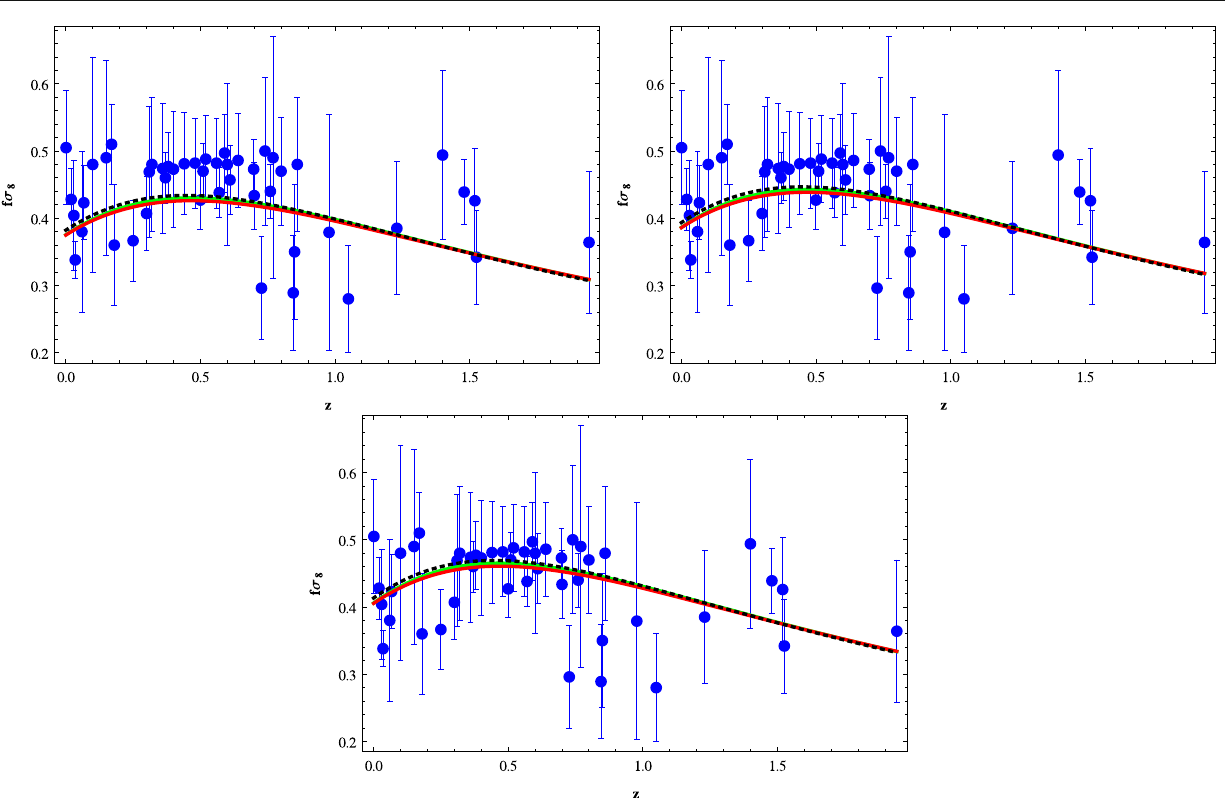
Fig. 4 The evolutionary trajectory of f σ 8 , as a function of redshift z , lutions of f σ 8 in a (cid:2) CDM and GCG models, respectively. Also, the is shown for the present model (green curve) by considering the values blue dots (with the error bars) correspond to the 47 Growth of mat- of (cid:6) b 0 = 0 . 046 ,(cid:6) dm 0 = 0 . 2508 ,ω de = − 1 . 041 , A s = 0 . 7373, and ter data points (redshift space distortions measurements) in the redshift η = 0 . 9443.Theplotsarefor σ = 0 . 75[61](leftpanel), σ = 0 . 772 range 0 . 001 ≤ z ≤ 1 . 944, obtained from different surveys and the 8 , 0 8 , 0 corresponding f σ 8 values are given in [64] and the relevant references [62] (right panel), and σ 8 , 0 = 0 . 811 [63] (lower panel), respectively. In each plot, the black and red curves represent the corresponding evo-